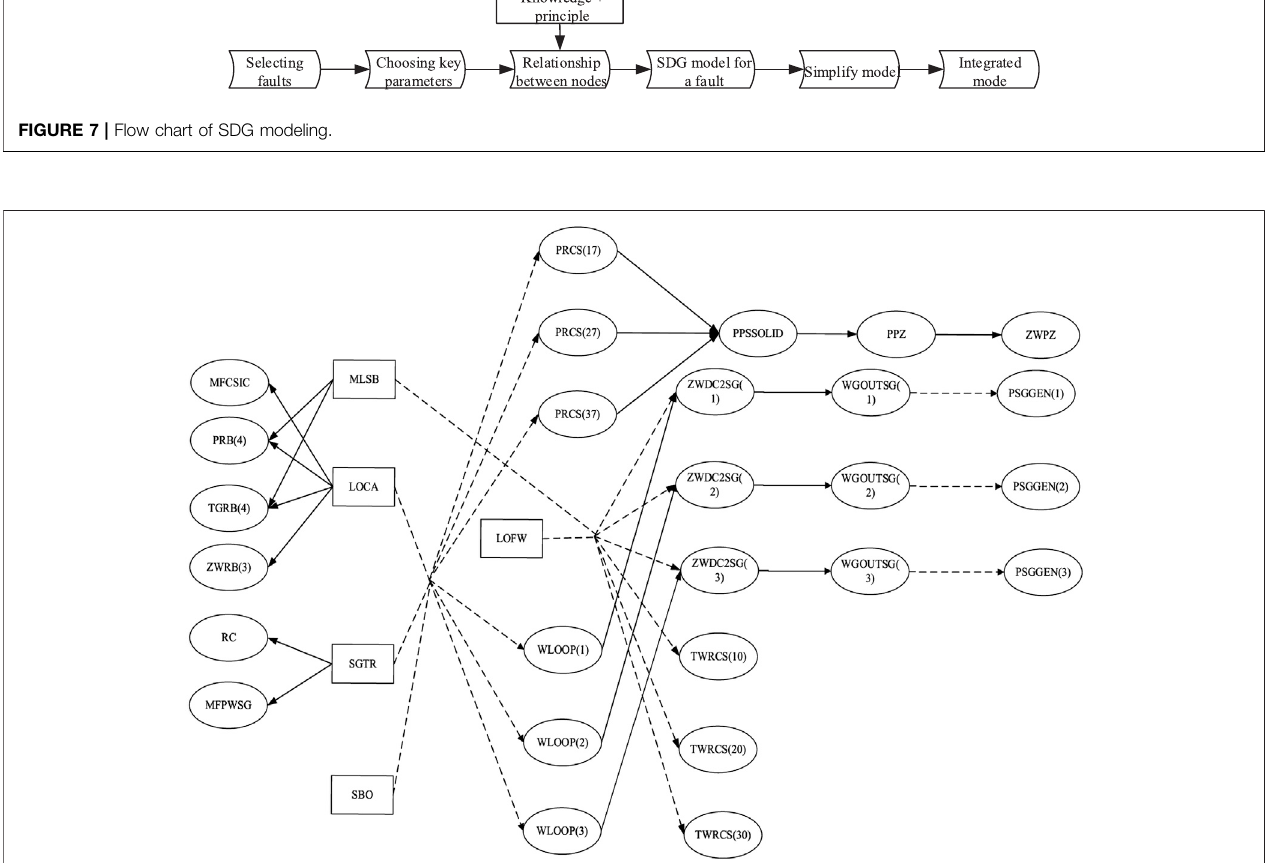
FIGURE 8 | SDG model for the pressurized water